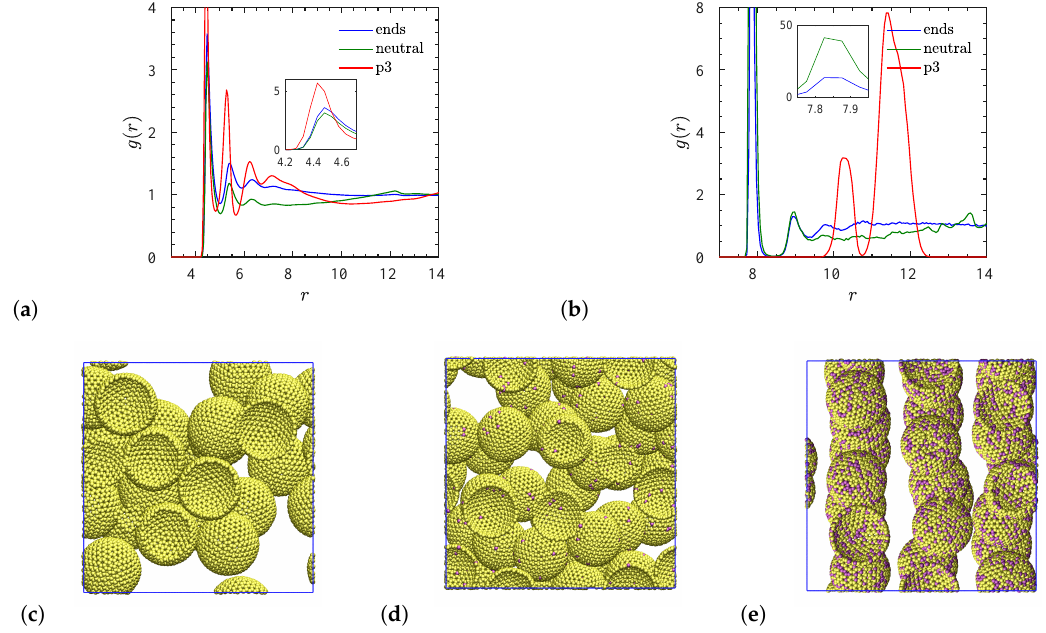
Figure 2. Radial distribution functions g ( r ) versus r in reduced LJ units (length unit σ ≈ 1 nm) for a system at NP volume fraction φ = 28.2% containing chains with a degree of polymerization N = 100. ( a ) NP center–monomer and ( b ) NP center–NP center distribution functions for the three types of chains. The insets show the corresponding values in the vicinity of the first peak in g ( r ) . Only with p3-charged chains the NP dispersion is achieved for this choice of N and φ . The bottom row shows corresponding top-view snapshots of systems for ( c ) neutral, ( d ) end-charged, and ( e ) p3-charged chains. Only NPs are shown, and polymers are hidden, for the sake of clarity. Yellow and purple spheres represent neutral and charged surface beads,